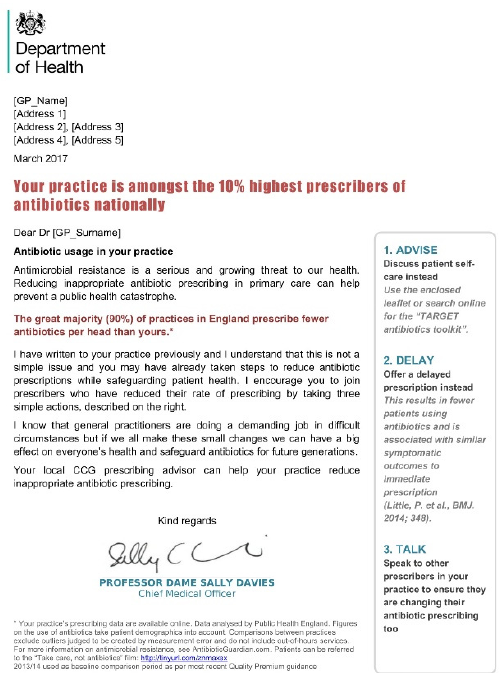
Figure 2. Example 1 of the workshop GP feedback letter with a bar graph in the centre and three key action points boxed to the right of the main text.